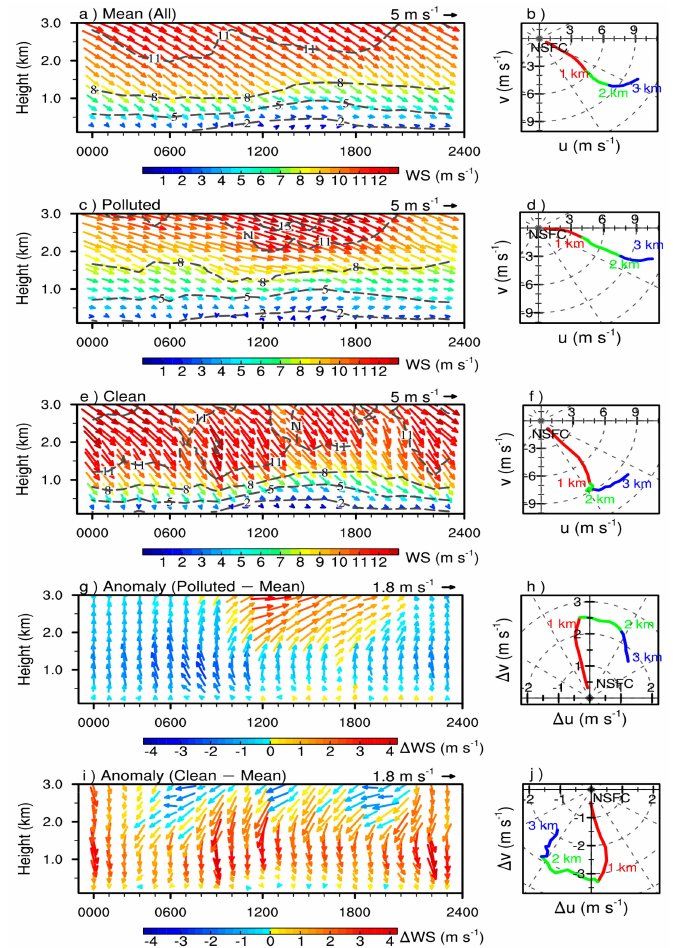
Figure 5. Height-resolved diurnal variation of horizontal wind vector under all-sky mean ( a ), polluted ( c ) and clean ( e ) conditions, and their corresponding anomalies (relative to mean wind) under polluted ( g ) and clean ( i ) conditions in Beijing from December 1, 2018, to February 28, 2019. Also shown are their corresponding hodographs in the panels ( b , d , f , h , j ) on the right-hand sides. Note the vectors in panels ( g )–( i ) show the resultant wind anomaly direction, and the vector length and color indicate the magnitude of the resultant wind anomaly relative to the average wintertime winds in